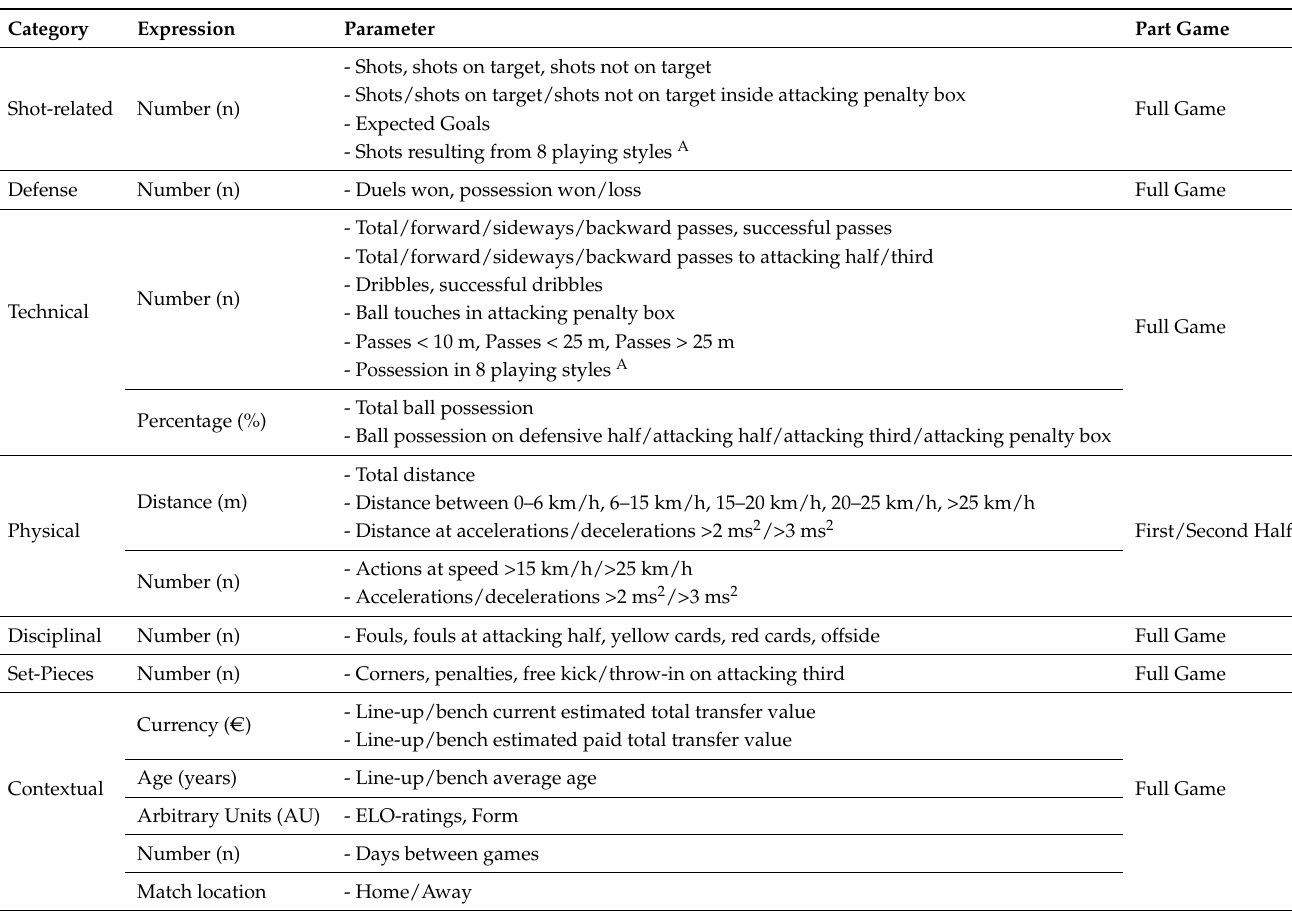
Table 1. An overview on the 100 included variables. A Playing styles: Maintenaince, Build-Up, Sustained Threat, Fast Tempo, Direct Play, Counter Attack, Crossing, High